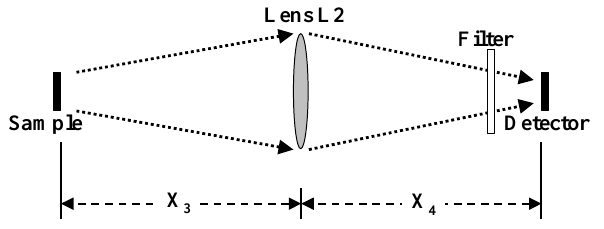
Figure 4. Schematic of the path for radiation from the sample, either fluorescence or transmission, through a lens and spectral filter to the